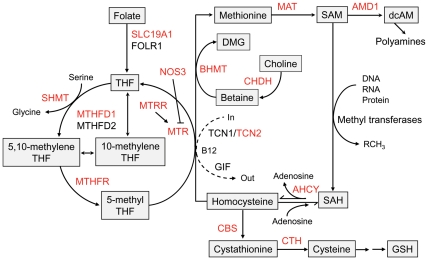
Homocysteine metabolism pathway.The genes selected for the study are marked in red fonts. Refer to Table 2 for gene names. Figure is adapted from Souto JC et al. (2005) Am J Hum Genet 76: 925–933 and Finkelstein JD (1998) Eur J Pediatr 157: S40–44.